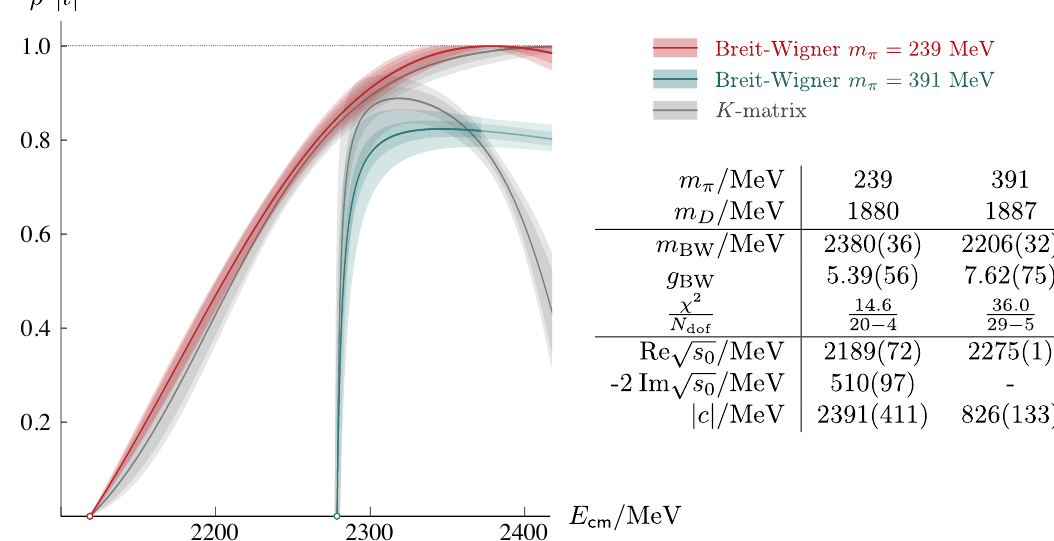
Figure 12. S -wave Breit-Wigner parameterisations compared to the reference K -matrix fits at both light quark masses — the numerical uncertainties shown include the statistical, and the mass, anisotropy variations summed together. The complex t -matrix pole position is indicated with mass √ √ m = Re s 0 , and width Γ = − 2 Im s 0 . The pole coupling | c | to Dπ is also indicated. The fit range used for the Breit-Wigner fit is shortened relative to the K -matrix at m π = 391 MeV as described in the text and indicated in the plot by the faded region at the highest